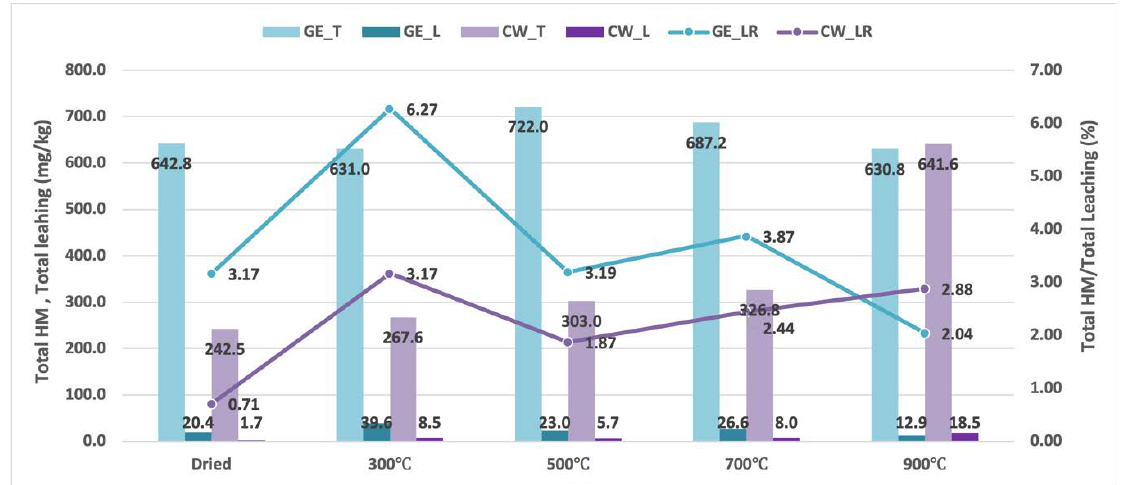
Figure 5. Total heavy metal amounts in biochar according to pyrolysis temperature. (T: Total content, L: Leaching amount, LR: Leaching amount/Total content).